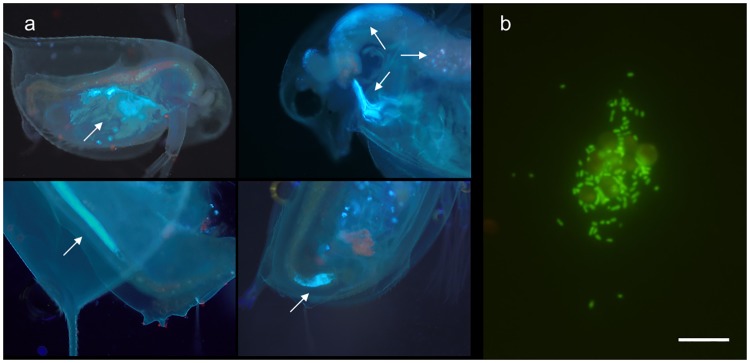
Ingestion and excretion of Escherichia coli by Daphnia pulex.(a) Gut content analysis of D. pulex following exposure to DAPI-labelled E. coli cells. White arrows indicate food boluses with compacted E. coli cells. Autofluorescence of ingested algae is also visible in some captions and varies from red to brownish, reflecting the stage of digestion of the chlorophyll. (b) Viability of E. coli following D. pulex gut passage as seen on an aggregate of E. coli rods and algal cells of Nannochloris atomus (Scale bar = 20 μm).